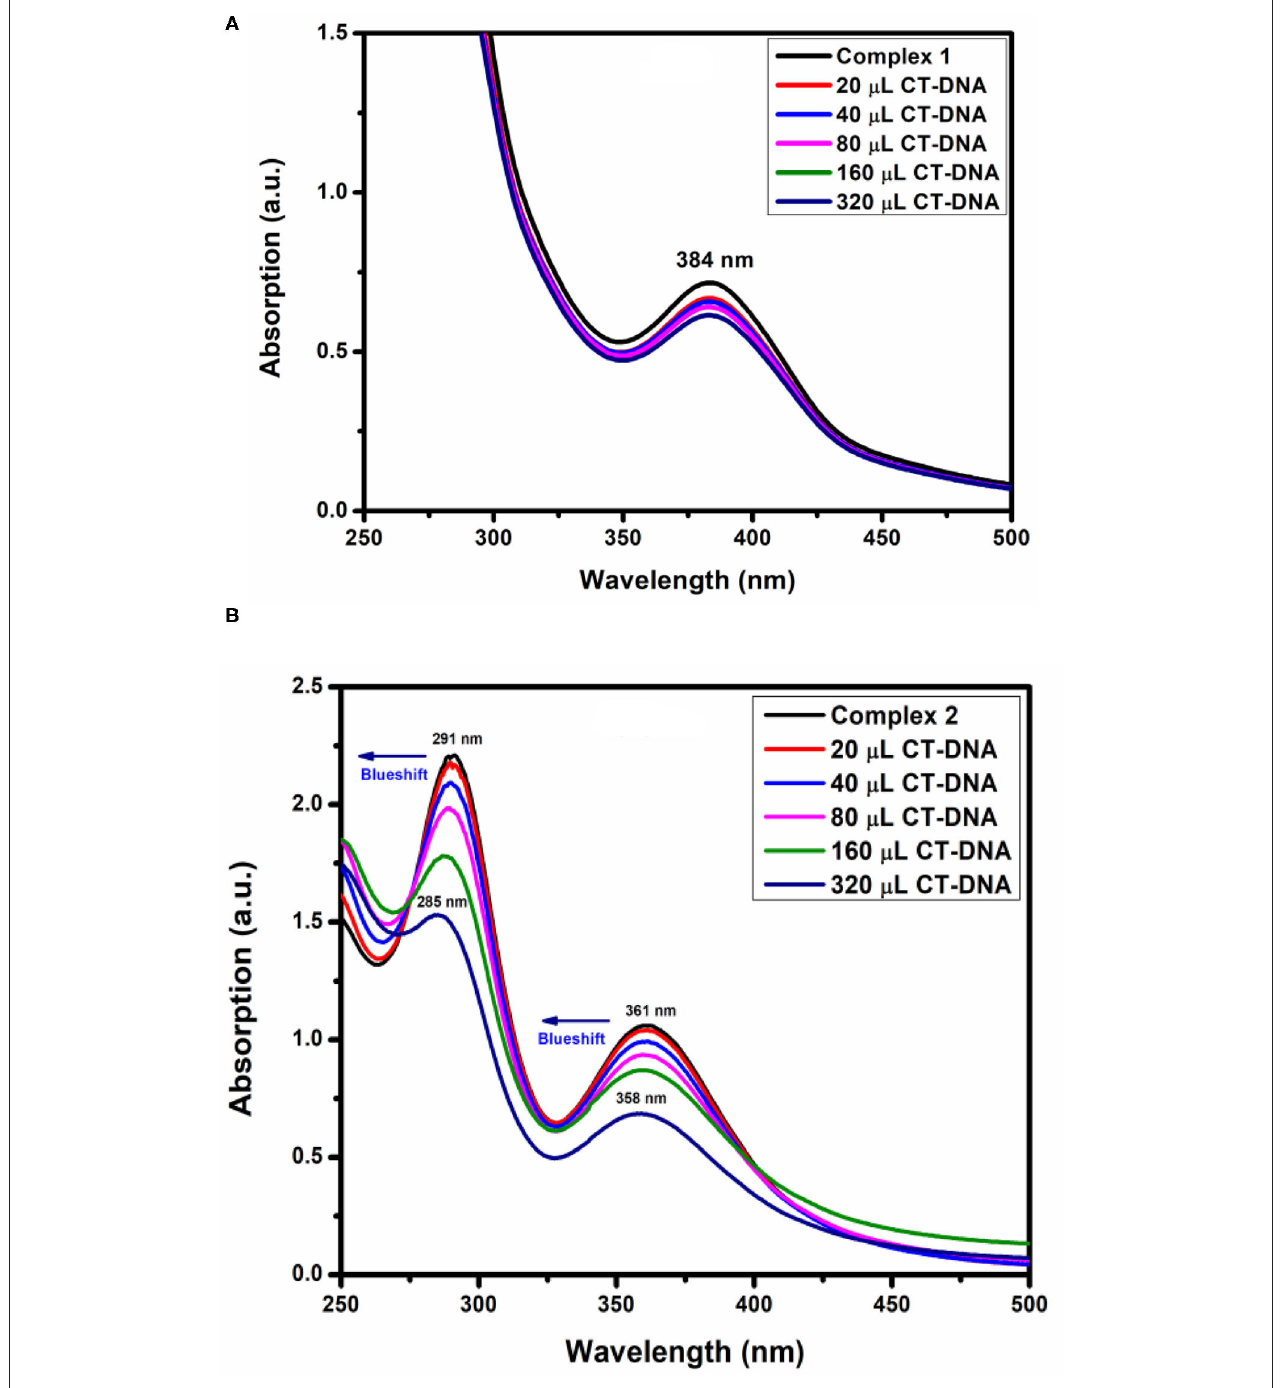
FIGURE 11 | DNA-binding study (A) complex 1 and (B) complex 2.